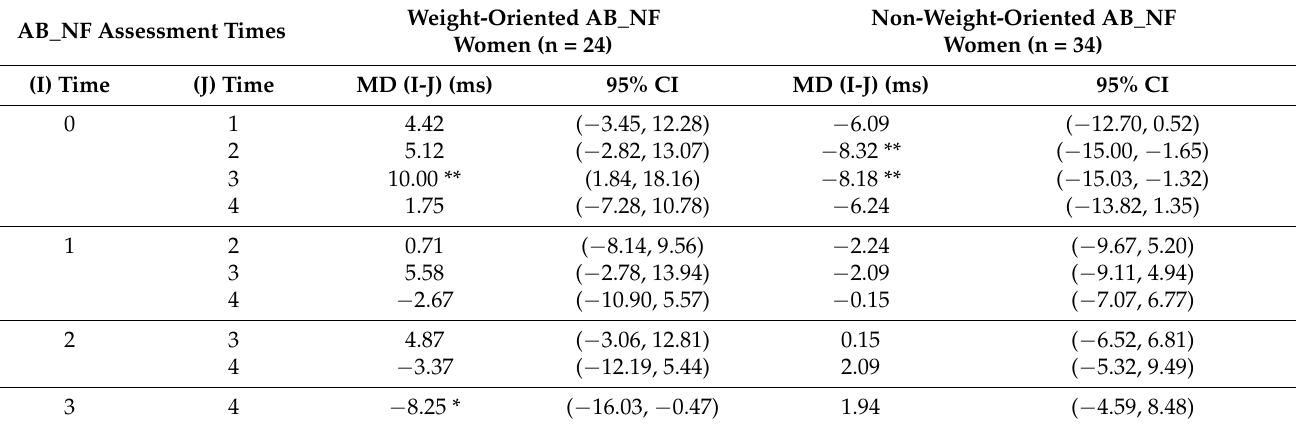
Table 3. Post-hoc analyses: pairwise comparisons-AB_NF Mean differences over time for each